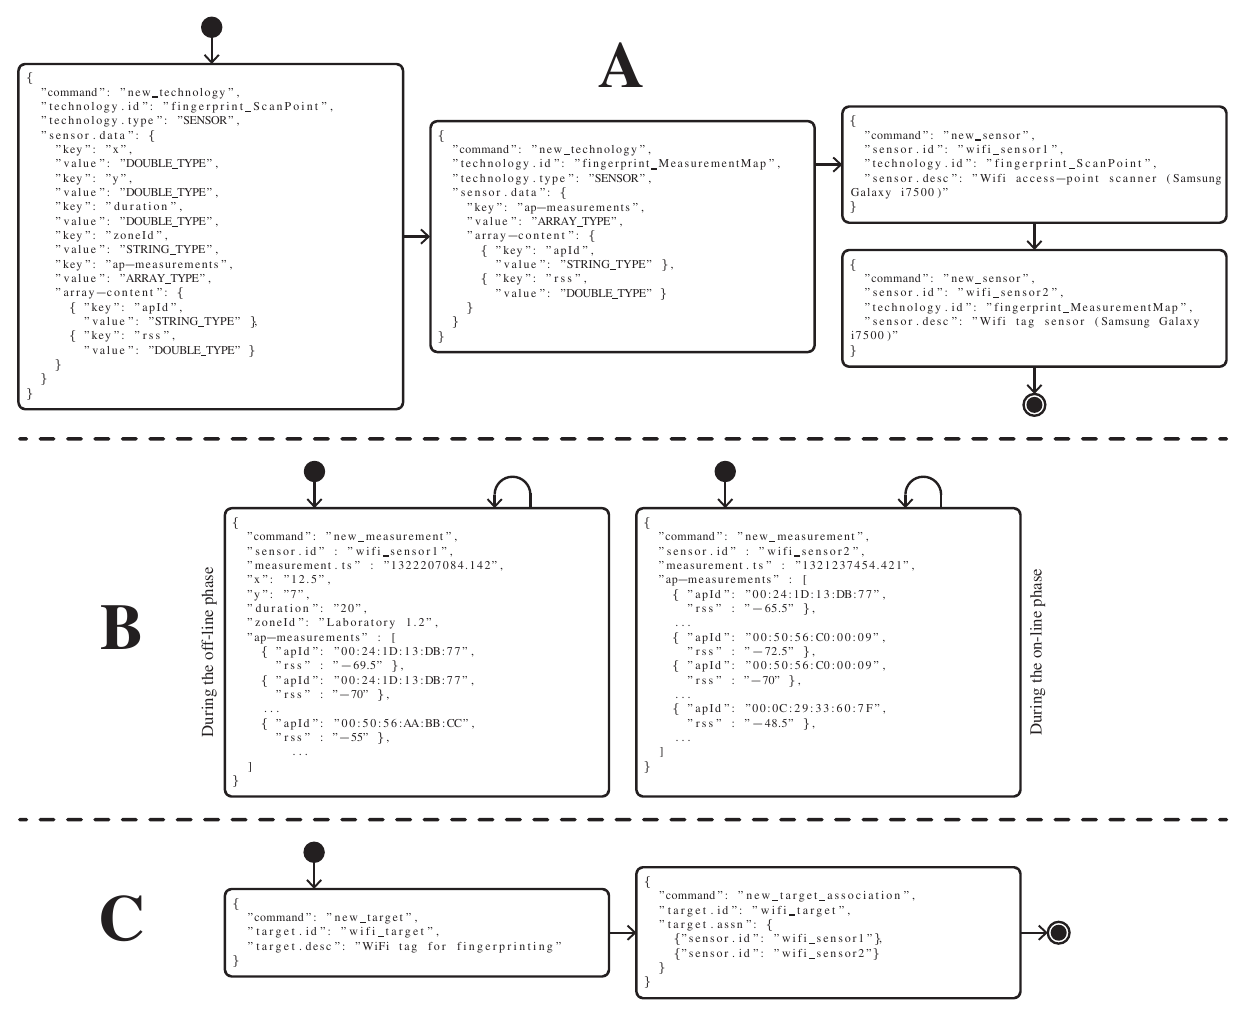
Figure 10. Groups of messages A, B and C of the fingerprint case